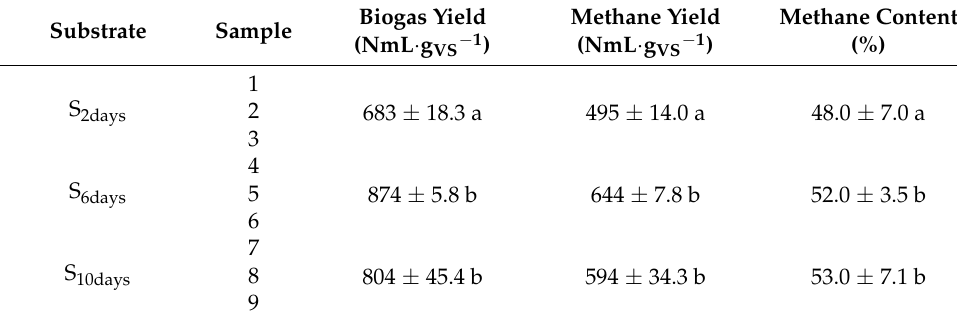
Table 4. Biogas and methane yields of the BMP tests.